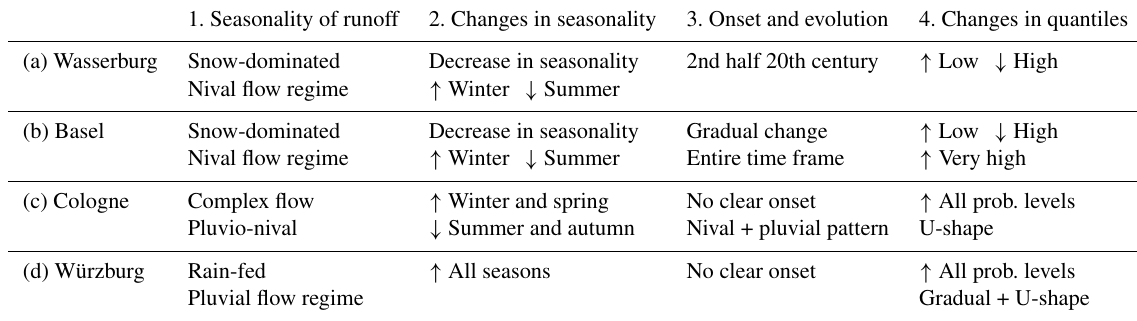
Table 2. Summary of analysis results presented in Fig. 4. Table arrangement reflects figure layout. 1. Seasonality of